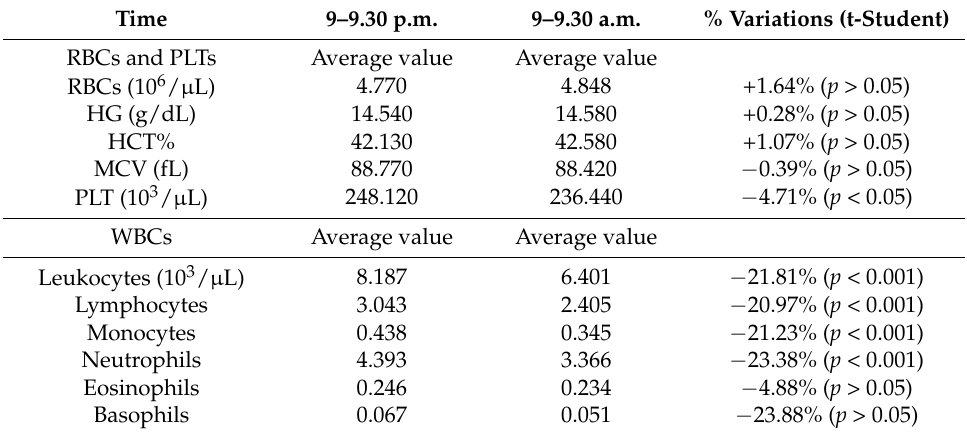
Table 3. Variations (p.m. vs. a.m.) of hemocytometric parameters in MLT